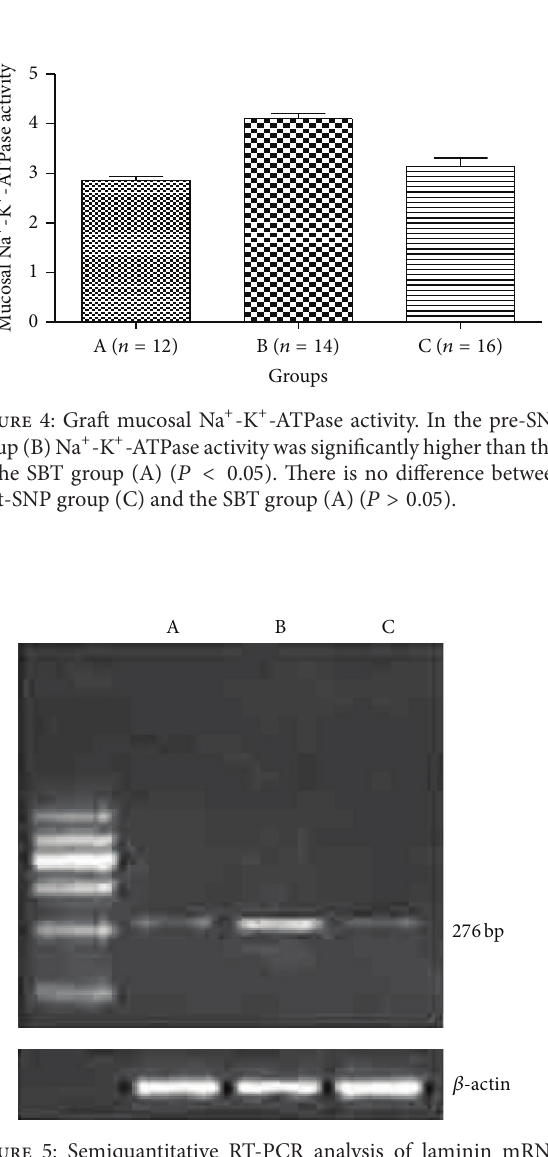
Figure 3: Histological examination of the graft 72 hours after SBT. (a) A representative sample from the SBT group ( 𝑛 = 12 ): obvious intestinal villi atrophy, destroyed villi, denuded villi, dilated capillaries, and some crypt layer injury. (b) A representative sample from the pre-SNP group ( 𝑛 = 14 ): some mild epithelial injuries are present. (c) Post-SNP group ( 𝑛 = 16 ): obvious destroyed, atrophic, and denuded villi and dilated capillaries are visible and some crypt layer injuries are present (HE × 200).